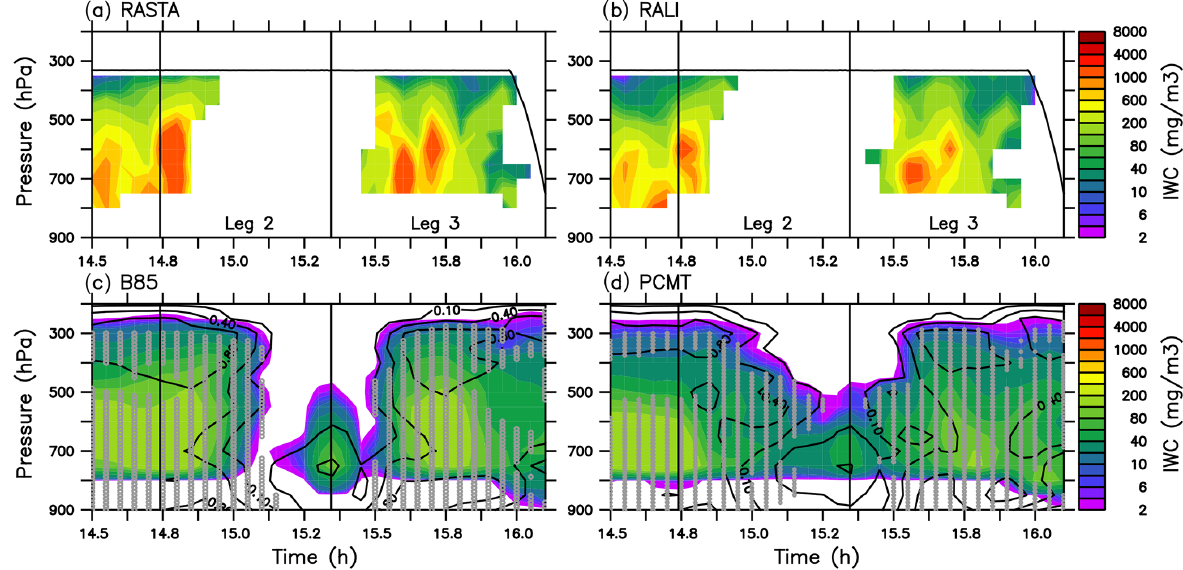
Figure 10. Ice water content (mgm − 3 ) for (a) retrieval from radar RASTA (b) retrieval from radar-lidar RALI along legs 2 and 3 of F7 (airborne level in black line). Total ice water content (snow + cloud ice water; mgm − 3 ; shading) and cloud fraction (black contours) for (c) B85 and (d) PCMT respectively. Grey circles represent WCB trajectories crossing F7.